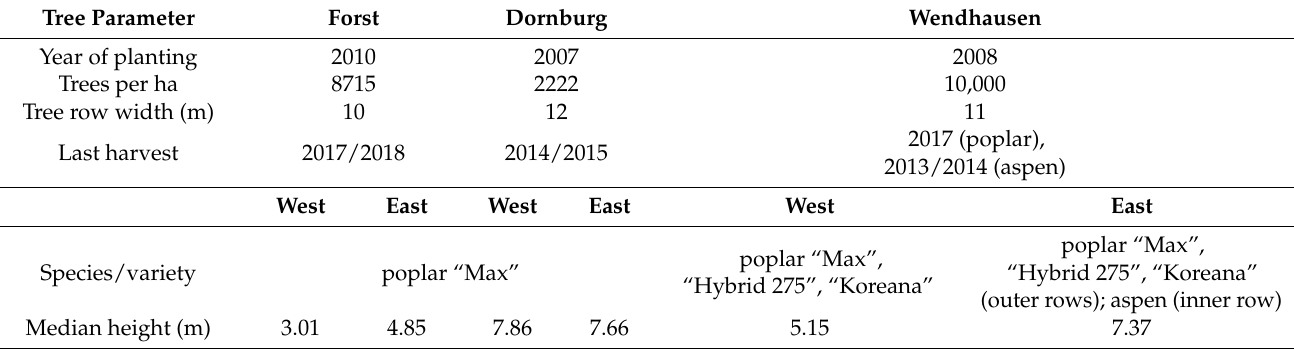
Table 1. Characteristics of eastern and western tree rows at the surveyed AFS